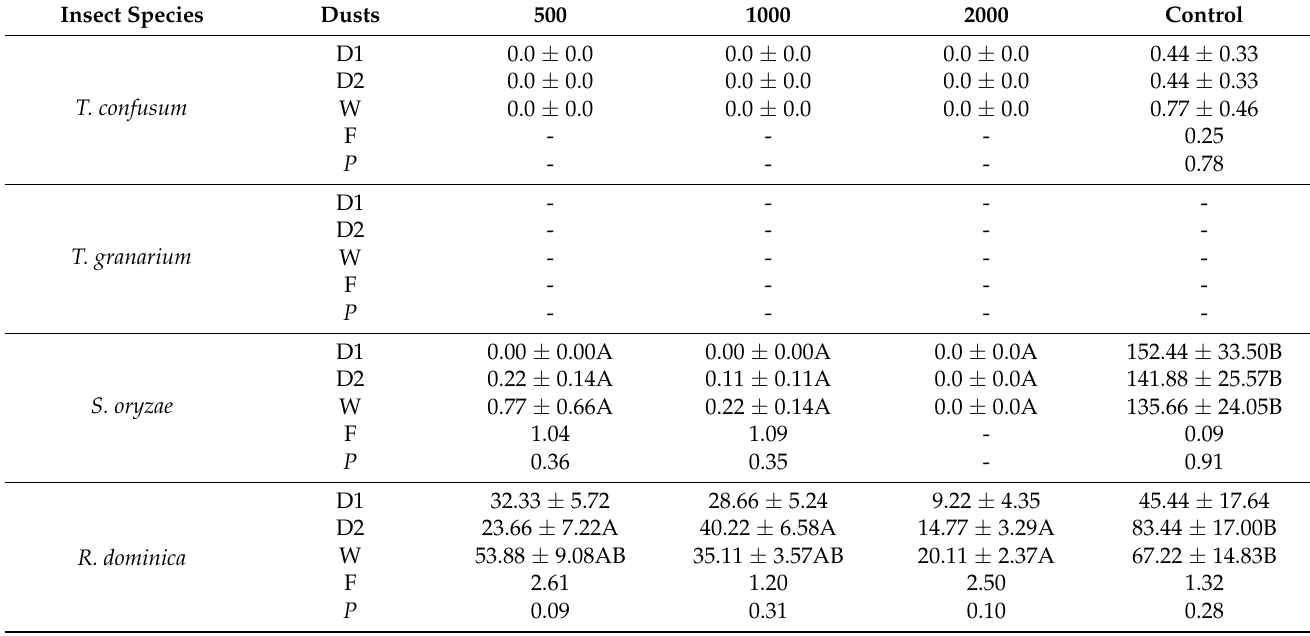
Table 8. Mean progeny production (number of adults per vial ± SE) of Tribolium confusum , Sitophilus oryzae , Rhyzopertha dominica, and Trogoderma granarium, 65 days after the removal of the parental individuals at three different dust formulations (D1, D2, and W) and four concentration rates (500, 1000, 2000 ppm, and